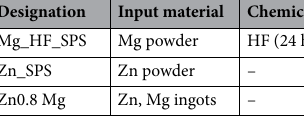
Table 2. Materials used for testing.